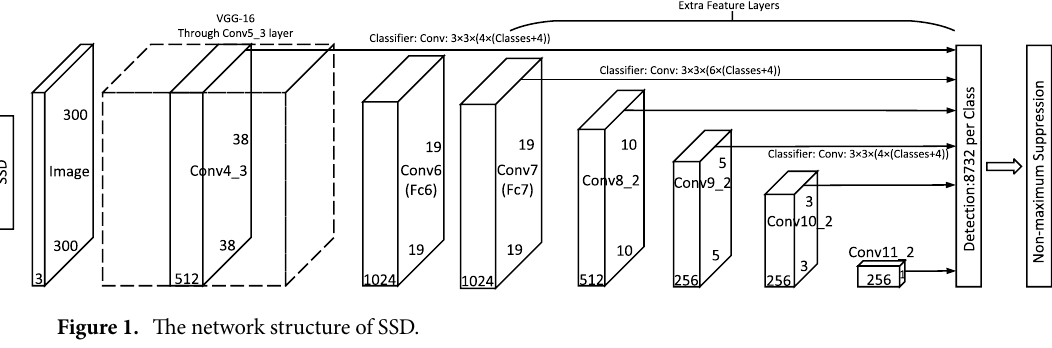
Figure 1. The network structure of